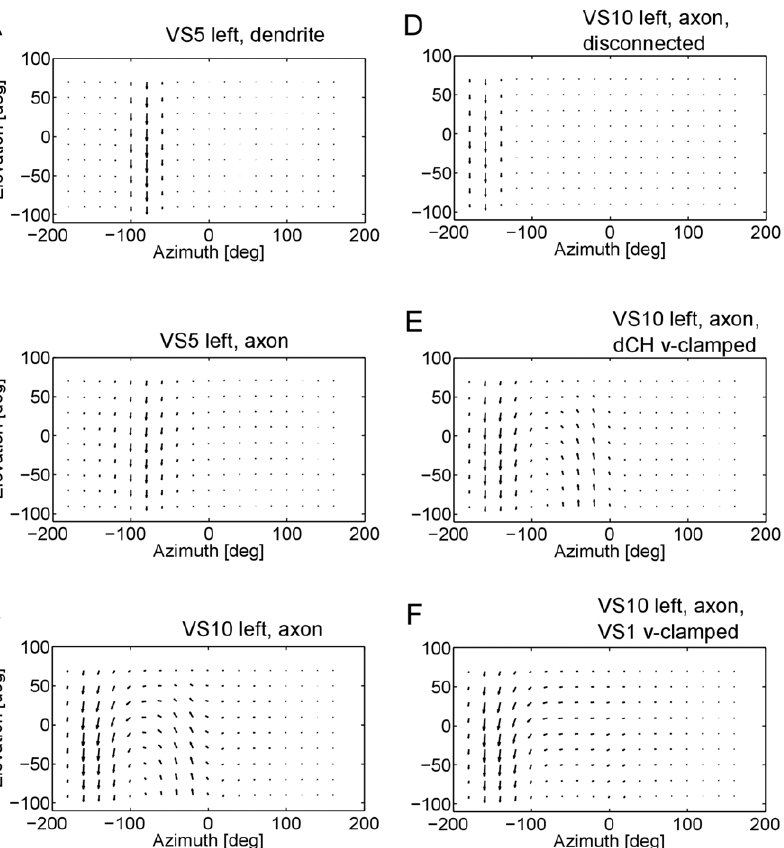
Figure 5. Receptive fields of lobula plate tangential cells. a,b Dendritic and axonal receptive field of the left VS5-cell. Due to axo-axonal gap junctions, the axonal receptive field is broadened relative to the dendritic one. c–f Axonal receptive field of the left VS10-cell under various conditions. Given full connectivity of the network, the receptive field shows a curl structure with an approximate center of rotation at 2 90 deg azimuth position (c). With all connections between the cells removed, only the downward sensitivity in the most posterior part of the visual field remains (d). With all connections intact but the left dCH-cell voltage-clamped, the horizontal sensitivity in the dorsal part of the visual field is missing (e). When the left VS1-cell is voltage clamped, the upward sensitivity in the frontal part of the visual field is removed (f).